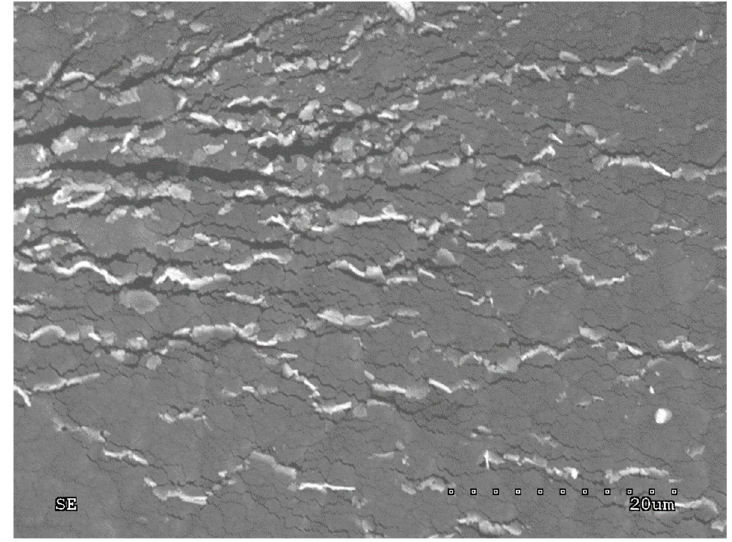
Figure 1. Microscopic image of the surface of samples with a thin Ag layer subjected to cyclic bending stress.